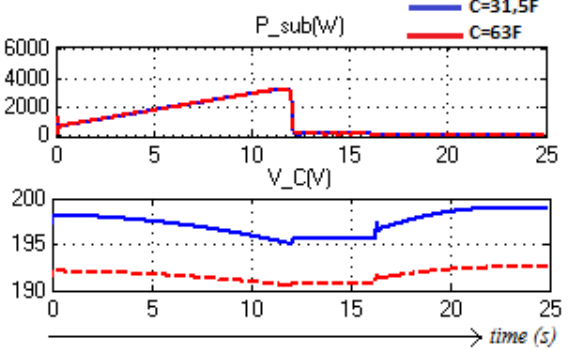
Fig. 11. Simulation diagrams of power for both C = 31.5 F and C = 63 F.